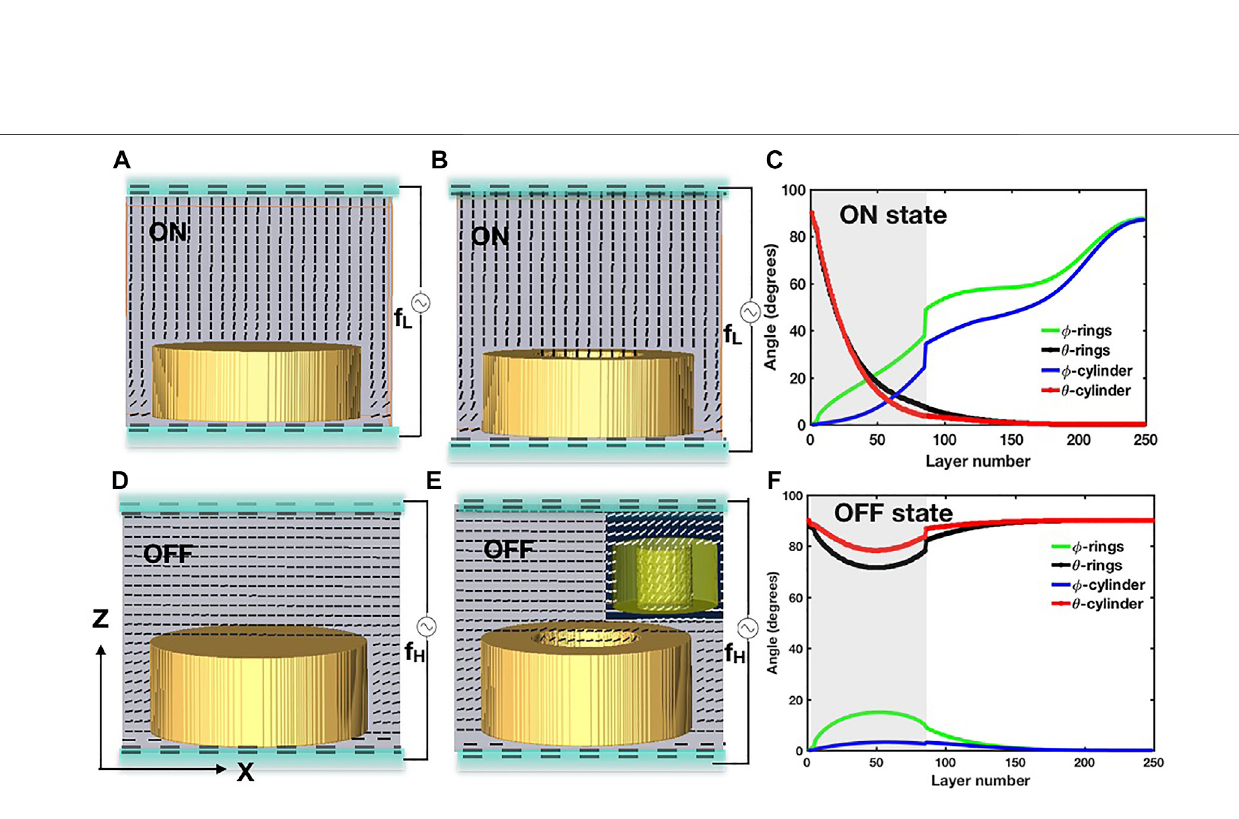
Frontiers in Physics |